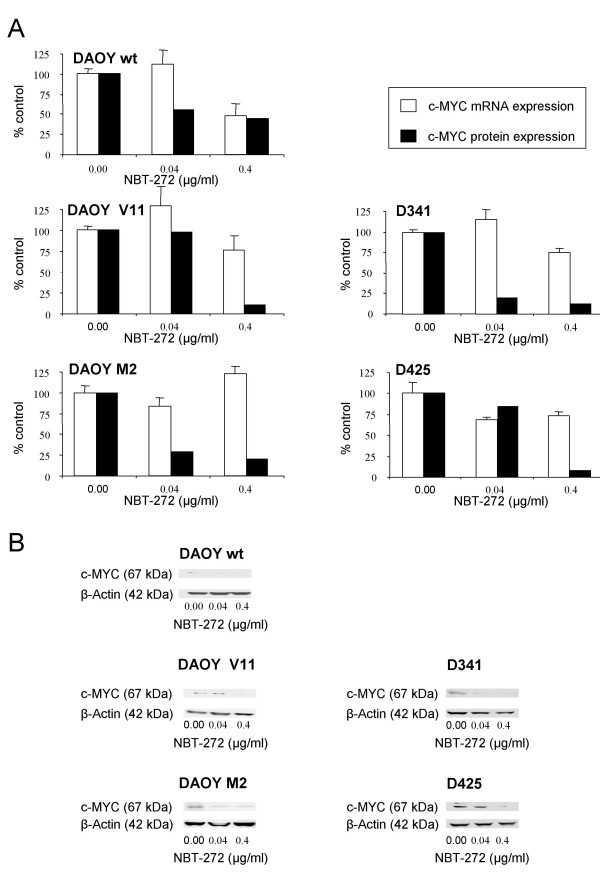
NBT-272 treatment of human MB cells results in down-regulation of c-MYC protein. NBT-272 treatment (24 h) of MB cells resulted in no consistent changes of c-MYC mRNA expression as determined by quantitative RT-PCR (A), but in a decrease of c-MYC protein expression as determined by Western blot analysis (A, B). Values represent the percentage of c-MYC mRNA (n = 3; ± SD) and c-MYC protein expression (representative from two independent experiments) compared with solvent only treated cells.